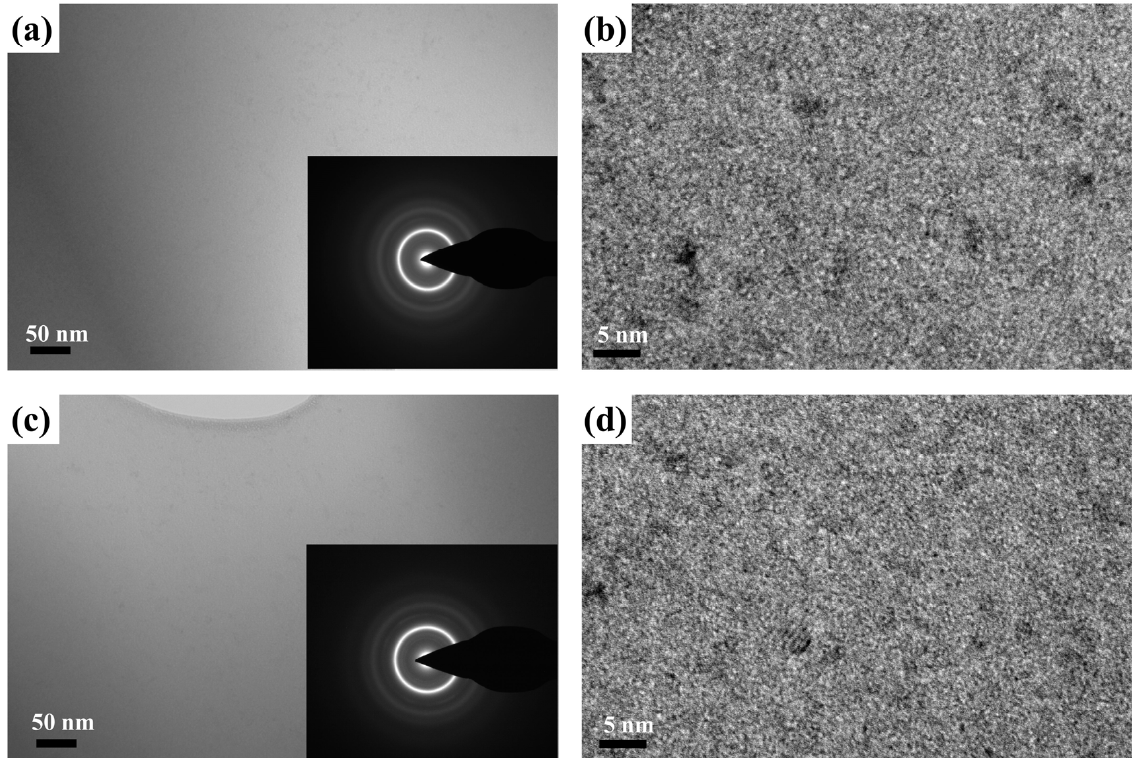
Figure 5. ( a ) Bright-field TEM and ( b ) HRTEM pictures of Fe 85.6 P 11 C 2 B 1 W 0.4 sample annealed at 683 K for 10 min. ( c ) Bright-field TEM and ( d ) HRTEM pictures of Fe 85.6 P 11 C 2 B 1 W 0.8 sample annealed